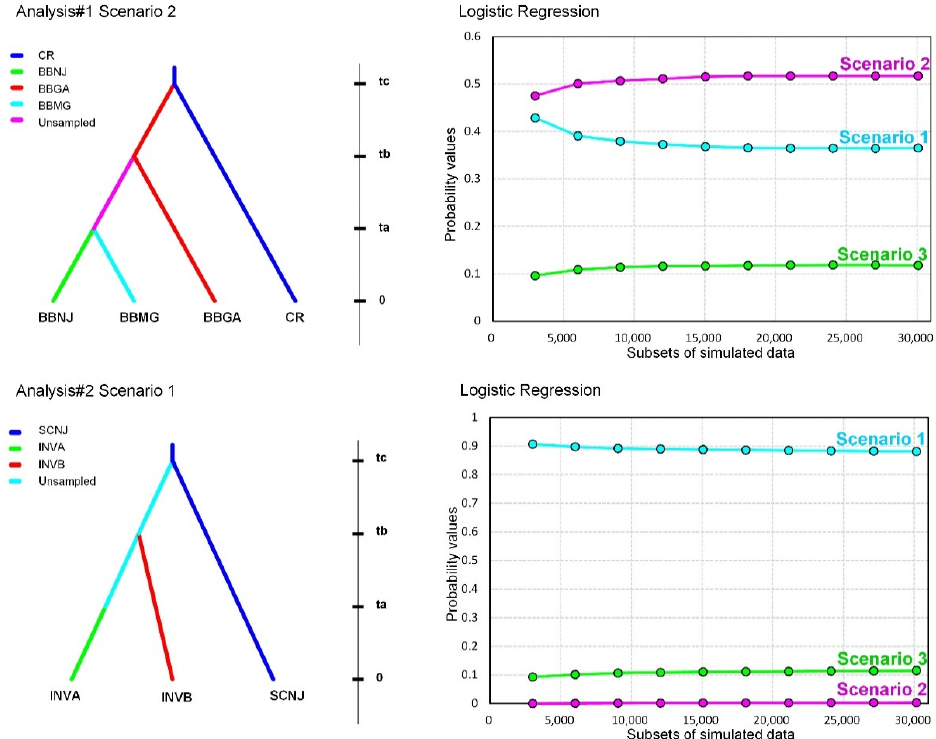
Figure 5. Scenarios (left panels) most supported by two independent analyses (Analysis #1 and Analysis #2), and probability values (right panels) from corresponding logistic regressions. Analysis #1 tested for serial divergence between Dasineura oxycoccana populations from blueberry and cranberry in the native range, whereas Analysis #2 tested for a divergence between a source (USA) of D. oxycoccana and the invaded region (Korea). Time (not to scale) is indicated on the right side of each scenario.